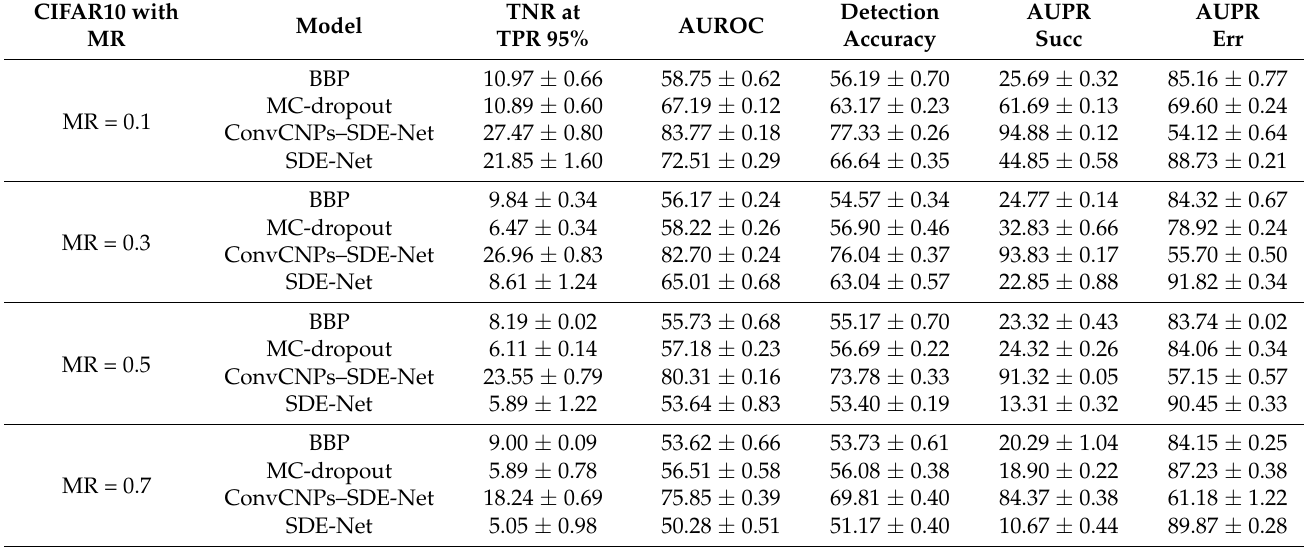
Table 6. Misclassification detection performance of the BBP, MC-dropout, ConvCNPs-SDE, and SDE-Net models